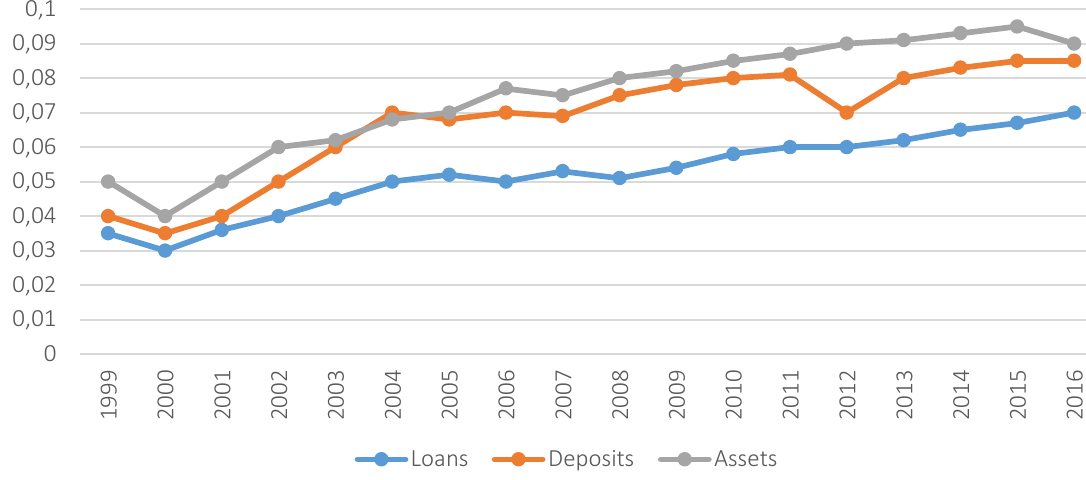
Figure 1. Islamic finance contributions to the banking sector in